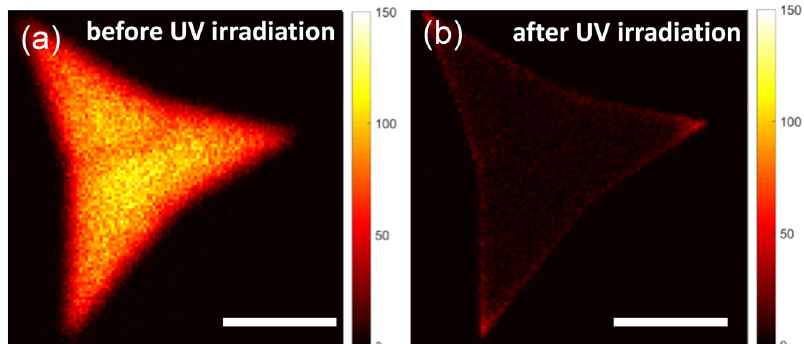
Fig. 5 Effect of UV irradiation on the PL emission of MoS 2 . a , b PL maps of an as-grown ML-MoS 2 crystal on a SiO 2 /Si substrate before ( a ) and after irradiation ( b ) with UV light ( λ = 365 nm, ∼ 30 mW cm − 2 , 5 min). The PL intensity signi fi cantly diminishes after exposure to UV light (scale bar: 20